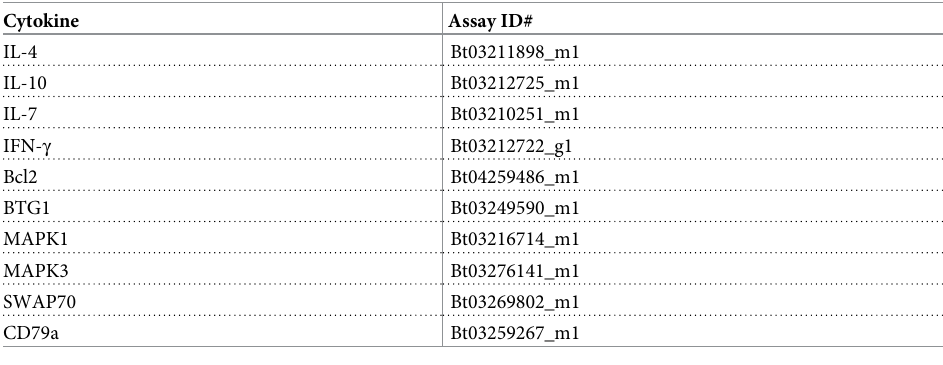
Table 2. Real-time PCR bovine cytokine gene expression 1 .